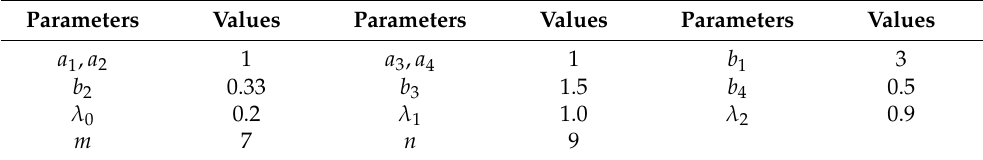
Figure 12. The tracking error norm comparison effect diagram of TSM tracking controller and FT-NITSM tracking controller. Table 1. Parameters and values applied in the